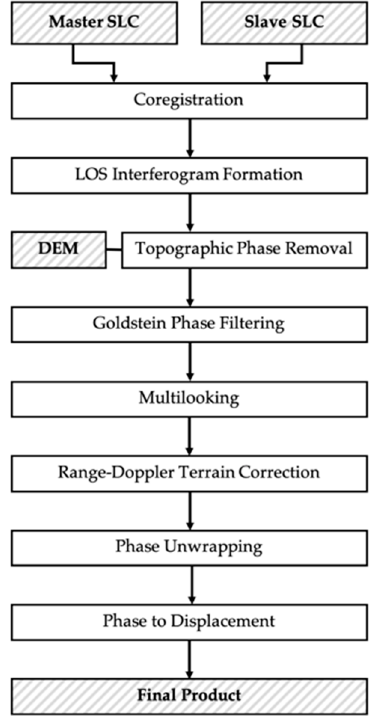
Figure A2. Flowchart of the successive operations carried out for the generation of an interferogram.